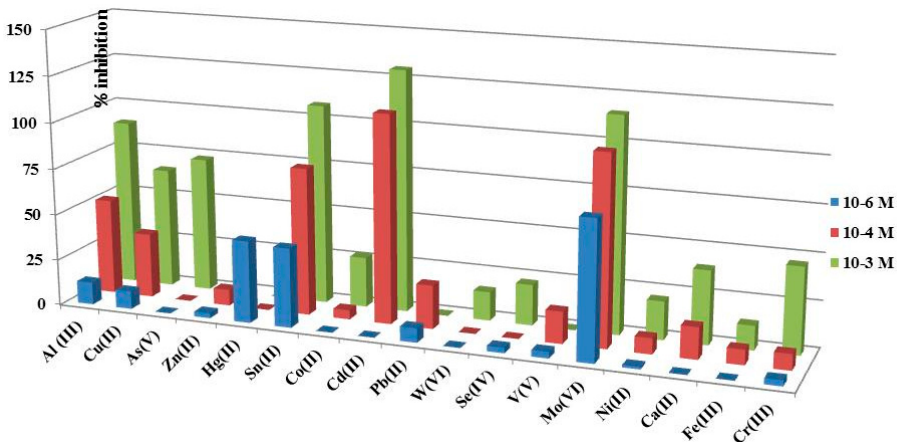
Figure 12. Inhibition percentage of current at SOD/PdNPs/SPC TTF E, (method B and CV2 conditions) in presence of: Al(III), Cu(II), As(V), Zn(II), Hg(II), Sn(II), Co(II), Cd(II), Pb(II), W(VI), Se(IV), V(V), Mo(VI), Ni(II), Ca(II), Fe(III) and Cr(III) at three concentration levels; [EPI] = 1.6 × 10 − 4 M; Britton